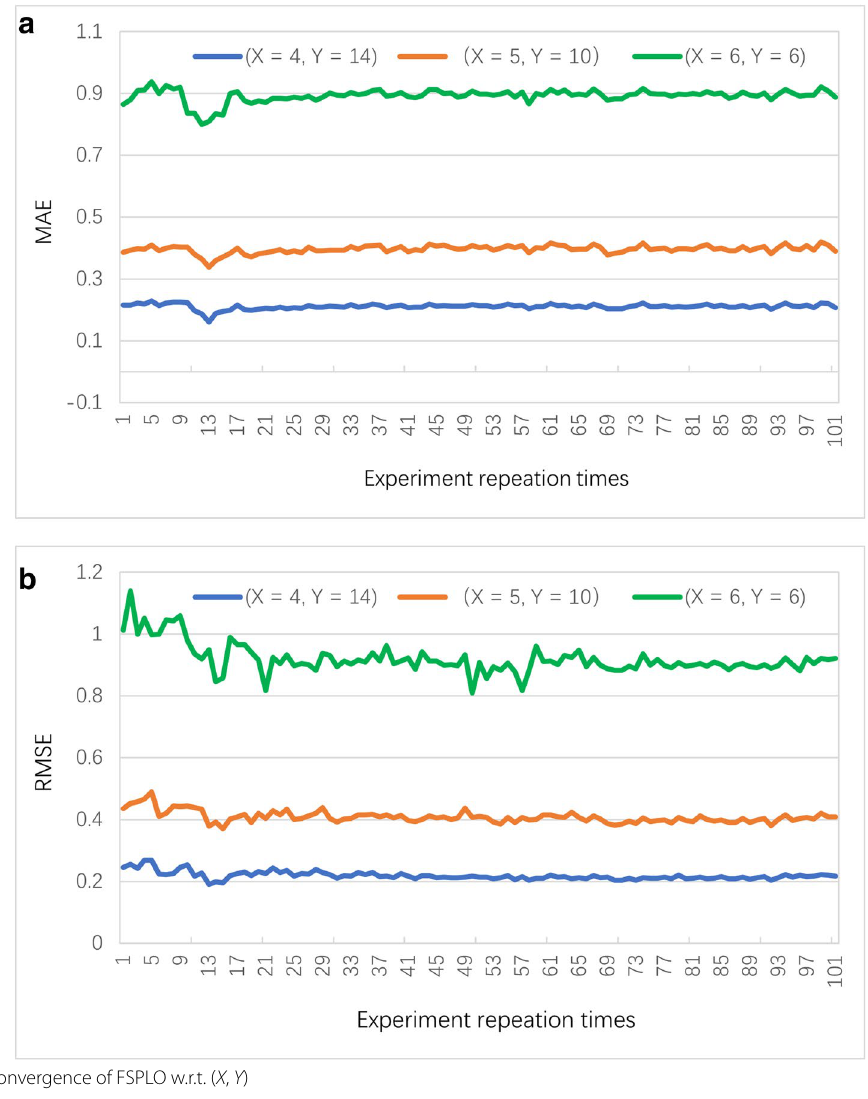
Fig. 7 Accuracy convergence of FSPLO w.r.t. ( X , Y